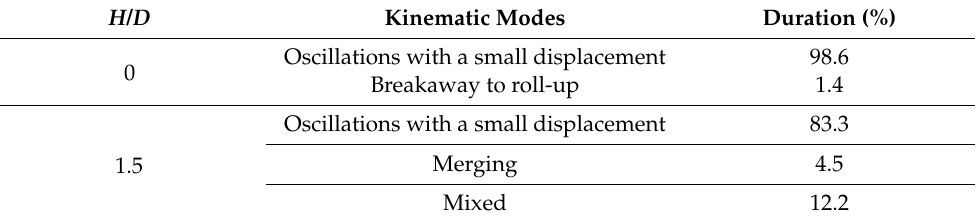
Table 1. Classifications and duration percentages of kinematic modes of the HSV when H / D = 0 and